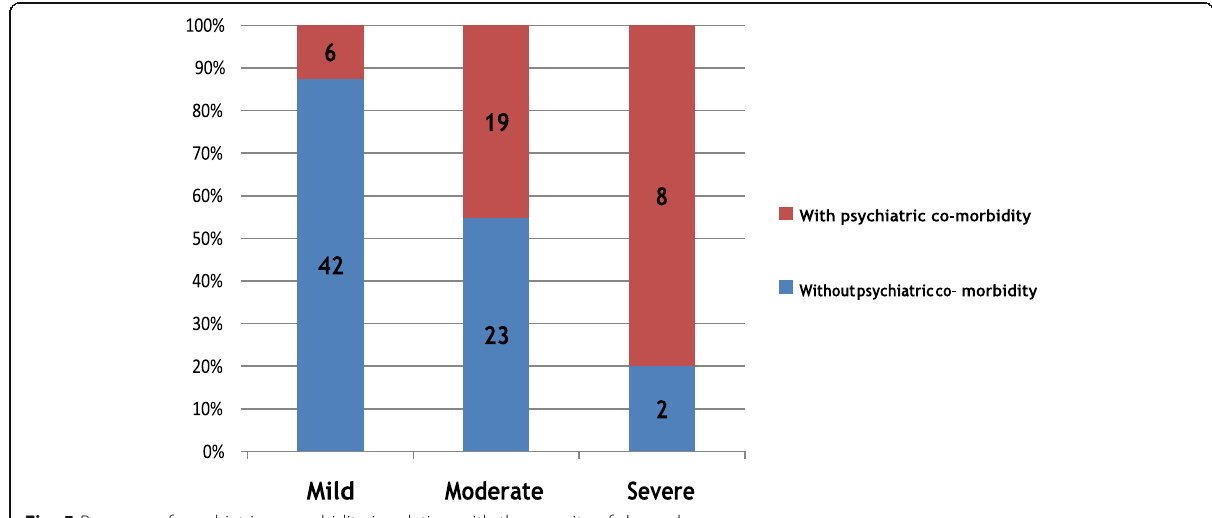
Fig. 5 Presence of psychiatric comorbidity in relation with the severity of dependence